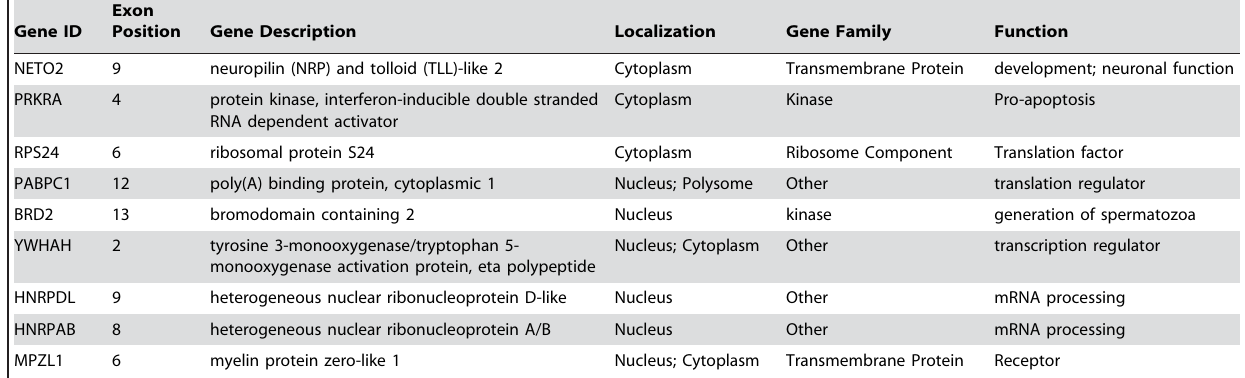
Table 5. Annotated as described in Table 1.